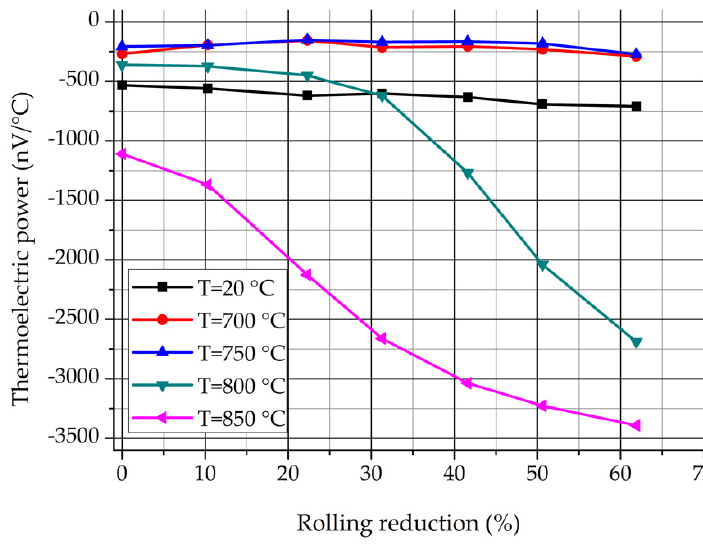
Figure 13. Values of the TEP in function of the rolling reduction.